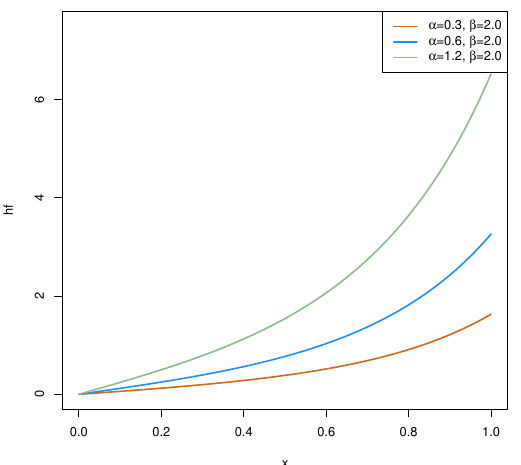
Figure 6. The hf when β ≥